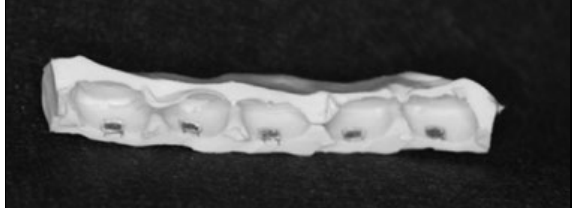
Figure 3. Transfer tray containing the brackets.